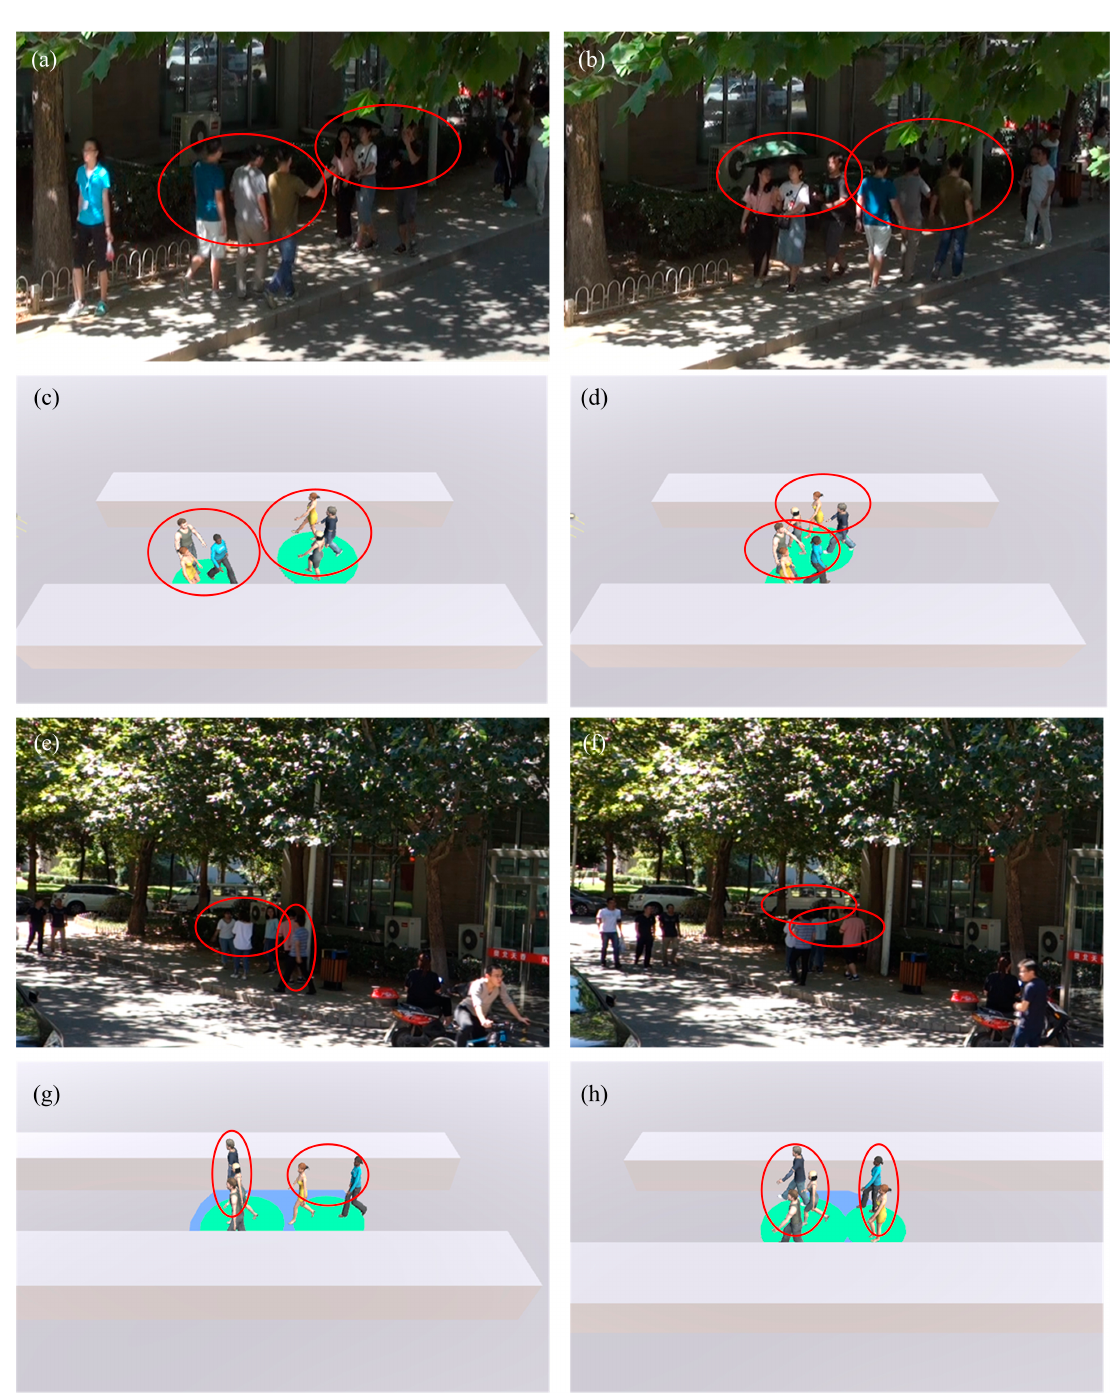
Figure 13. Comparisons between real data and simulation results of the SGFM. ( a , b ) Avoidance in the real world. ( c , d ) Simulation results of avoiding behavior. ( e , f ) Coordinate behavior in real world. ( g , h ) Simulation results of coordinate behavior.